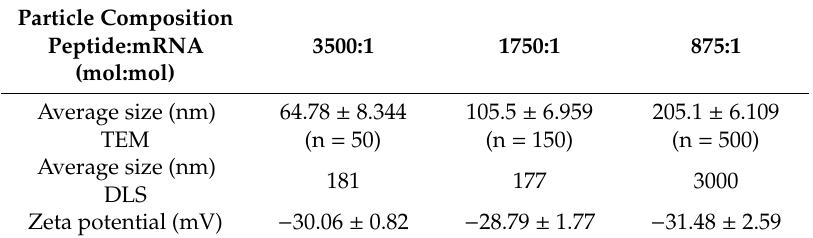
Figure 3. HA-coated p5RHH-WNT16 mRNA NPs were generated by mixing 10 µ mol of p5RHH with 1 µ g mRNA (peptide:mRNA ratio 3500:1), 2 µ g of mRNA (peptide:mRNA ratio of 1750:1), or 4 µ g of mRNA (peptide:mRNA ratio 875:1). Inset (in the left panel) shows the NP at a higher magnification. Table 1. Characteristics of NPs at various peptide:mRNA ratios.